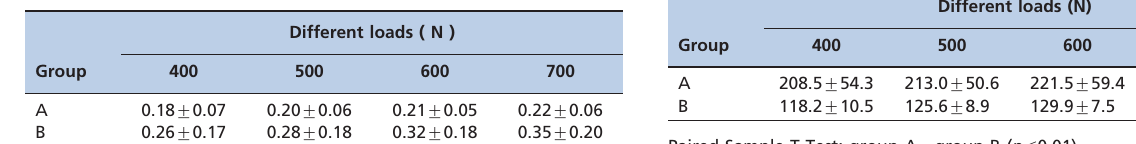
Table 3 - Different loading-lateral displacement of the posterior column inner wall in the sitting position (x ¡ s mm).